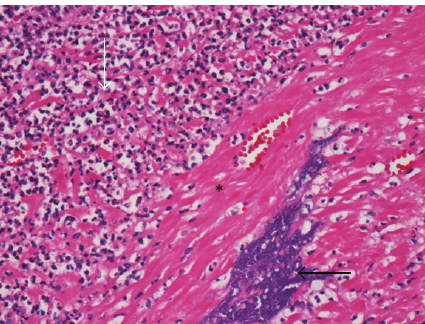
Figure 2: High power magnification with Hematoxylin and Eosin staining revealing a diffuse infiltrate of polymorphonuclear white blood cells (white arrow), necrotic anuclear smooth muscle cells (asterisk), and purulence (black arrow).